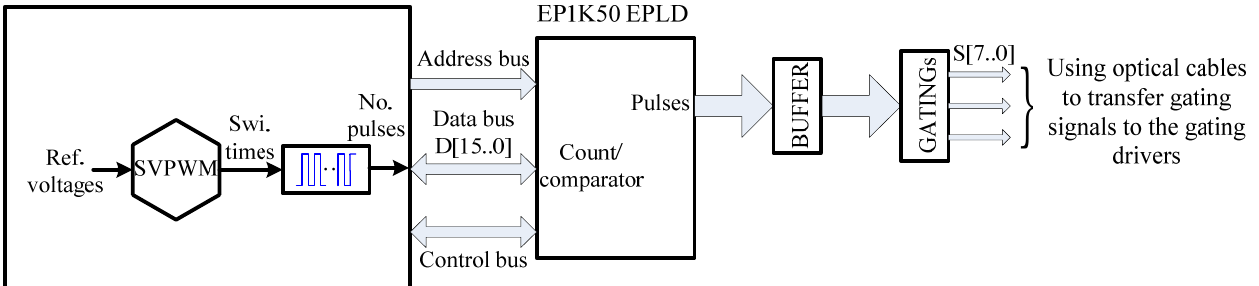
Figure 9. Gate pulse generation scheme based on the DSP and EPLD.